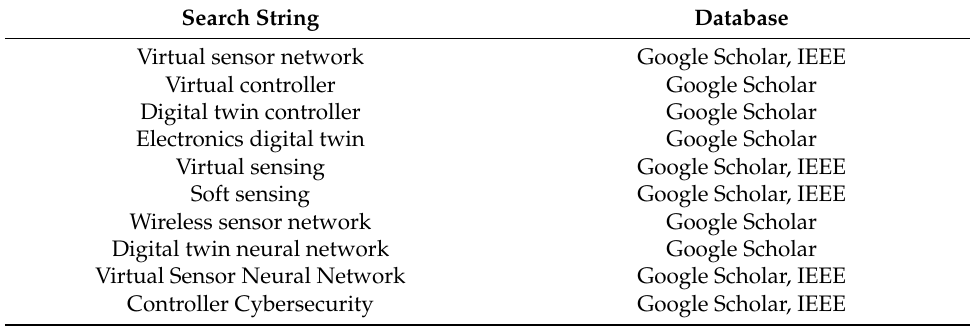
Table 2. Search strings and databases searched on for the literature